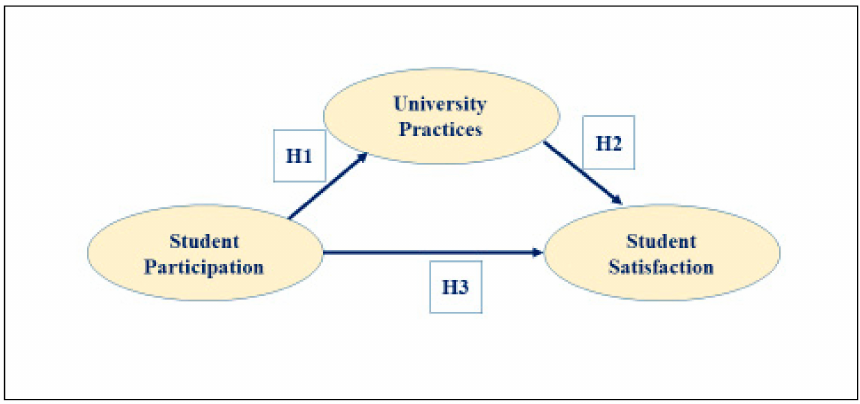
Figure 1. Conceptual model of the university social responsibility (USR). Source: